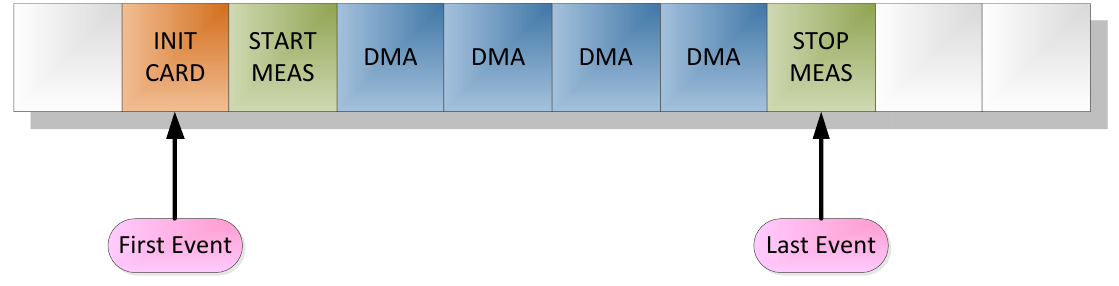
Figure 5. Example of event queue implemented in Slave